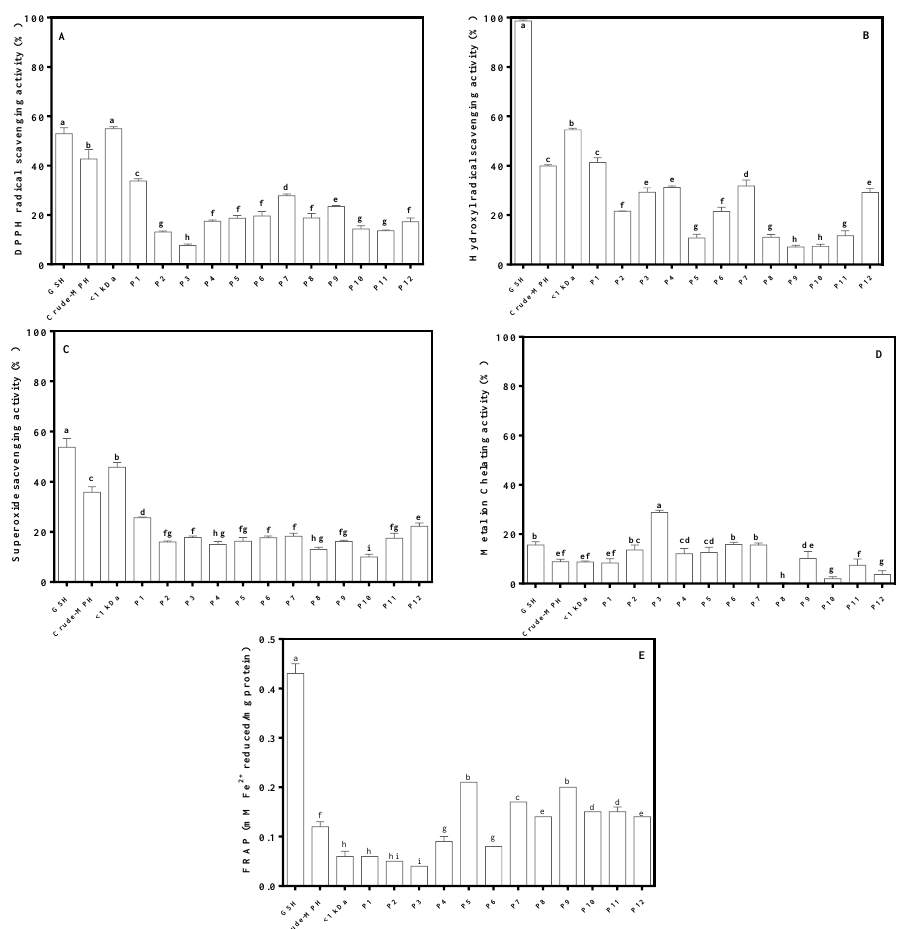
Figure 2. Antioxidant activities of crude mung bean meal protein hydrolysate (MMPH), <1 kDa peptides and peptide tides and peptide fractions derived from the 1st round of RP(C12)HPLC (P1–P10): DPPH scavenging fractions derived from the 1st round of RP(C12)HPLC (P1–P10): DPPH scavenging activity ( A ), hydroxyl radical scaveng- activity ( A ), hydroxyl radical scavenging activity ( B ), superoxide radical scavenging activity ( C ing activity ( B ), superoxide radical scavenging activity ( C ), FRAP ( D ), and metal ion chelation activity ( E ). Data are ex- pressed as mean ± standard deviation ( n = 3). a,b,c,… Different letters indicate significantly different mean values ( p < 0.05).